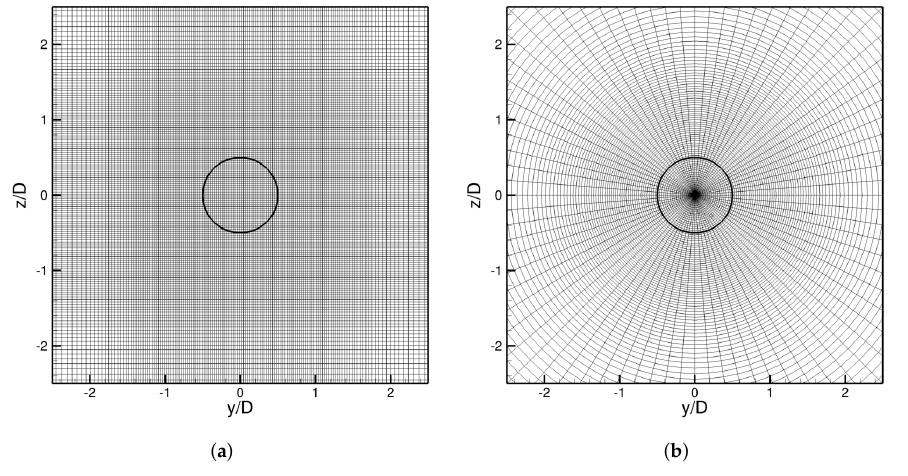
Figure 2. Computational meshes: Cartesian ( a ) and cylindrical ( b